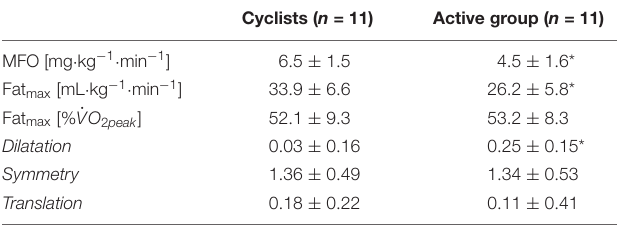
TABLE 2 | Whole-body fat oxidation parameters and SIN model variables.